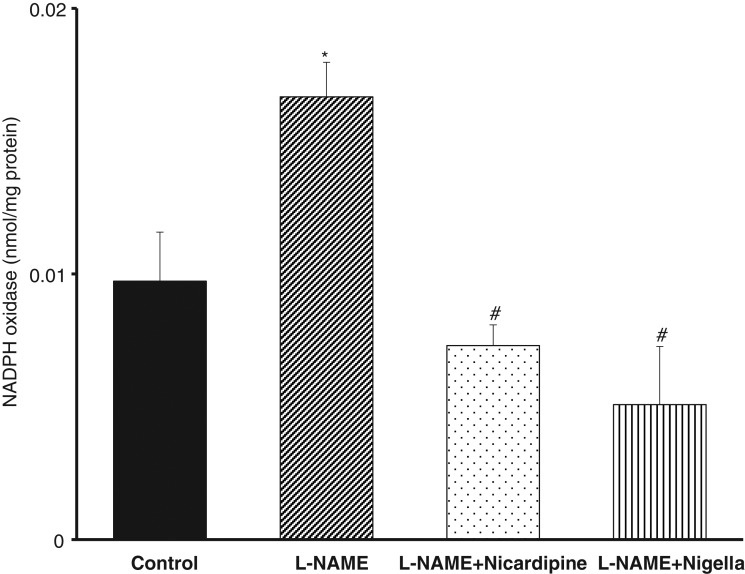
Effects of N. sativa oil on NADPH oxidase enzyme activity in L-NAME administered rats. The bars represent the mean±SEM (n=6). *p<0.005 versus control, #p<0.05 versus L-NAME.